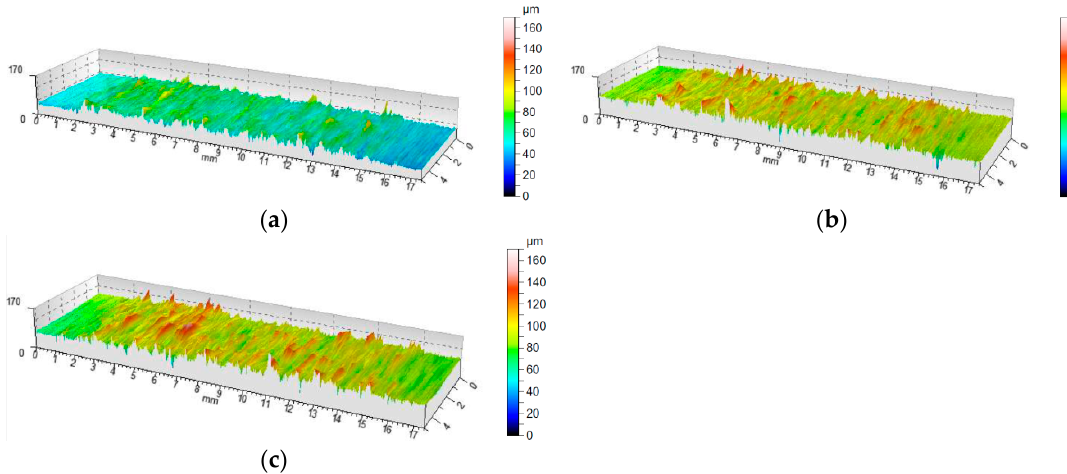
Figure 15. The topography of the surface drilled with a TiAlN coated tool: ( a ) Cutting speed 105 m/min and feed per revolution 0.1 mm/rev; ( b ) cutting speed 105 m/min and feed per revolution 0.15 mm/rev; ( c ) cutting speed 105 m/min and feed per revolution 0.2 mm/rev.